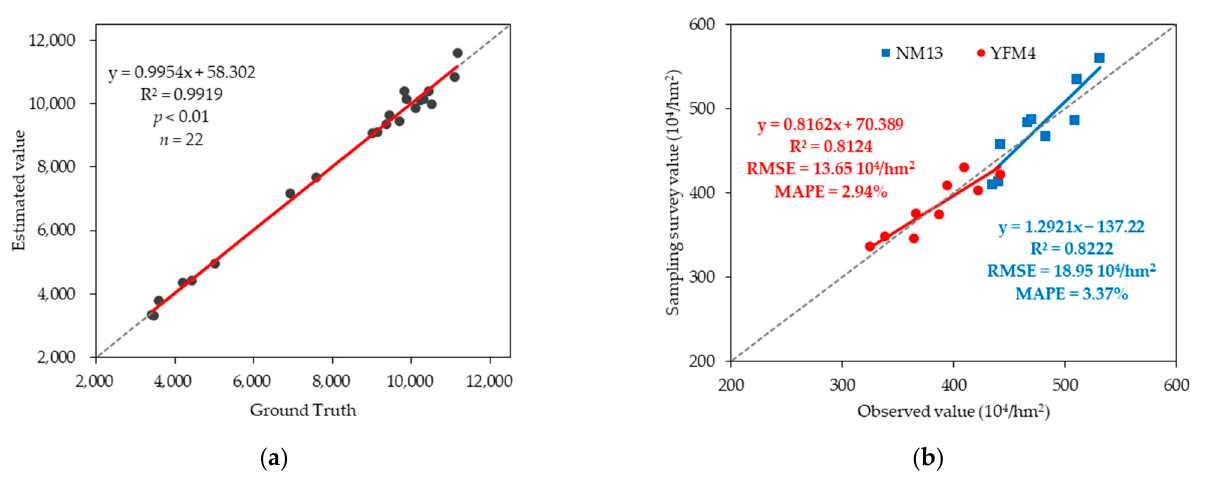
Figure 10. The results of the sampling survey method. ( a ) The relationship between the estimated value of training sample images and its ground truth. ( b ) The comparison between the regional sample survey method and manual survey method.